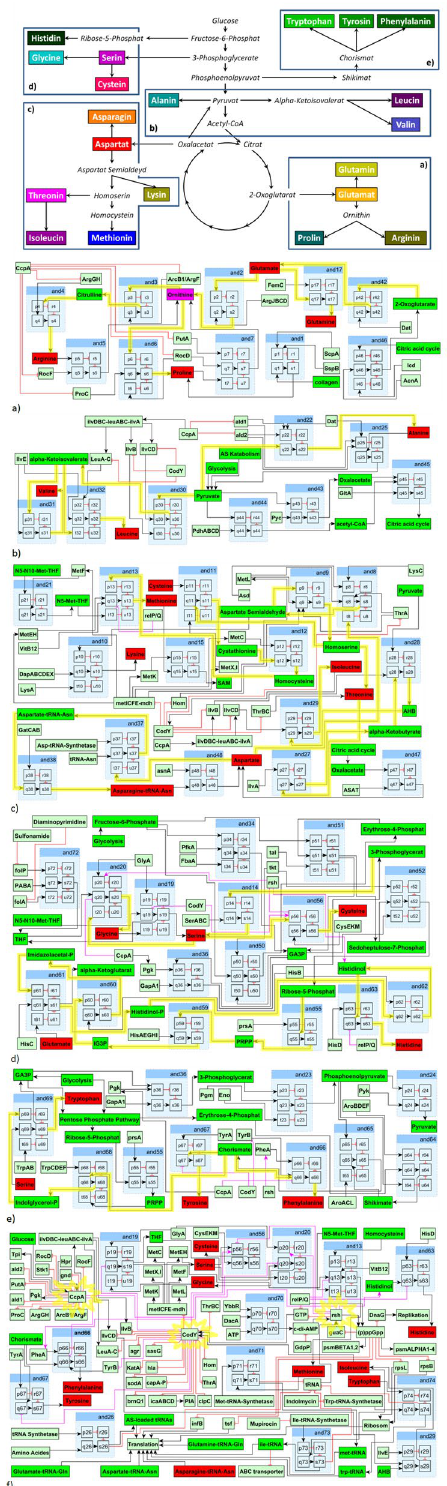
Figure 2. AA-Metabolism overview and sections of the Network: Top: Schematic overview display of the AA metabolism, in particular the anabolic pathways and which AA is synthesized through which pathway. "( a – e )" in the overview display describe the sections which are reflected then below in the following detailed sections of the network. Bottom: subpanel "( f )" shows the interconnections of the three central nodes CcpA, CodY and RSH. In the online supplement we provide the entire network as a detailed, zoomable vector graphic for close inspection of the network by the interested reader (file: Online-E-Supplement-Fig.